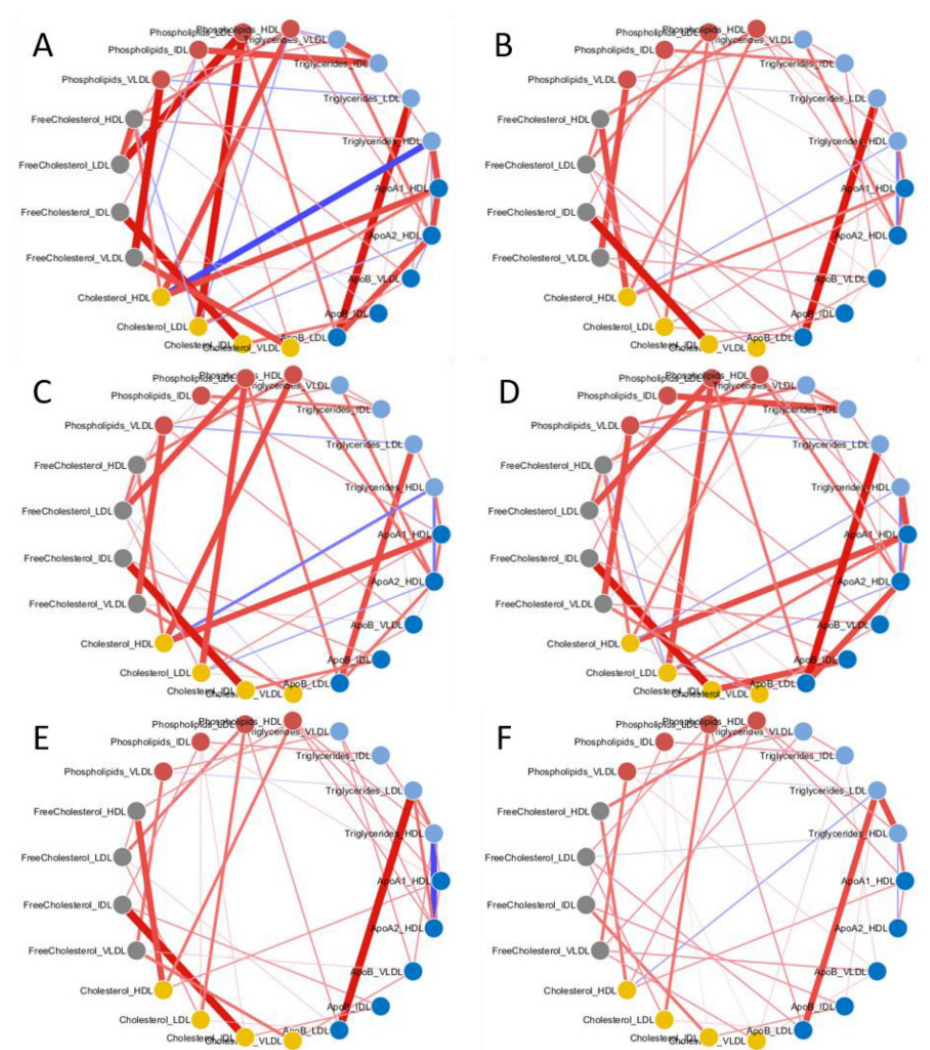
Figure 4. Association networks of lipoprotein and lipid main fractions (nodes) for ( A ) women, ( B ) men, ( C ) young men, ( D ) old men, ( E ) young women, and ( F ) old women. Associations (edges) are quantified by partial correlation estimated with a Gaussian Graphical Model [37] in combination with the PCLRC probabilistic algorithm [25]. Positive partial correlations between nodes are colored in red; negative partial correlations between nodes are colored in blue. The edge weights are proportional to the edge weight. Nodes are color-coded according to the 5 lipid groups considered: Apo (dark blue), cholesterol (yellow), free cholesterol (grey), phospholipids (red), and triglycerides (light